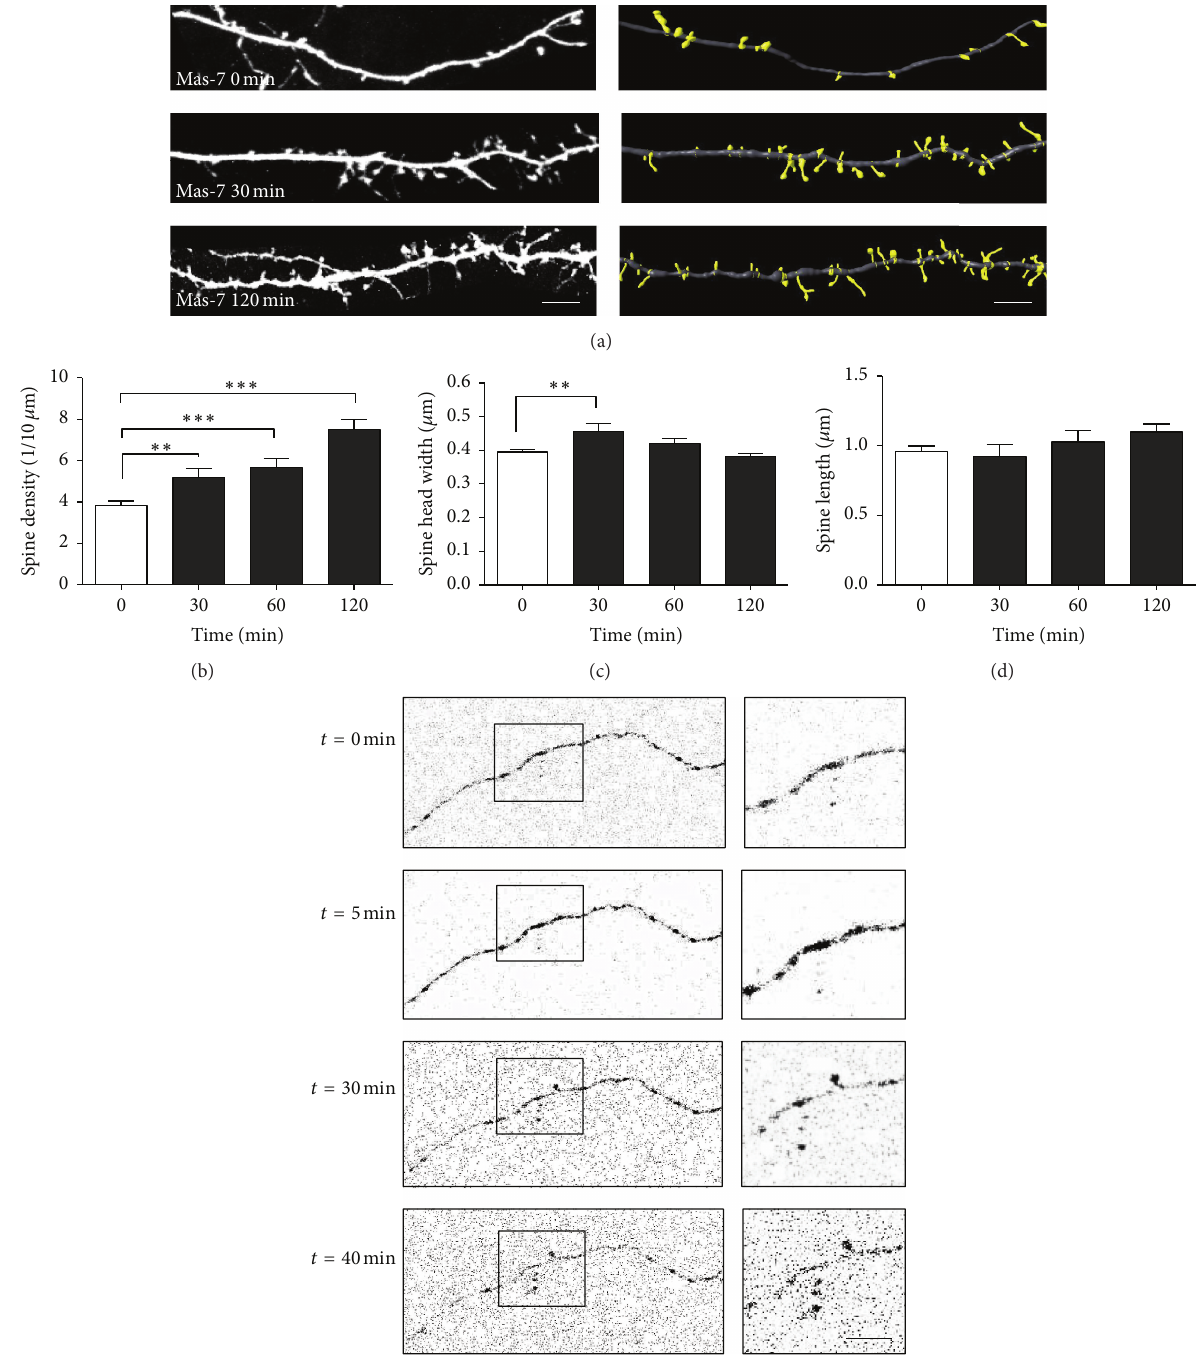
Figure 4: G 𝛼 o activation by Mas-7 regulates dendritic spine morphogenesis. (a) Left panel , representative images of 14 DIV hippocampal neurons treated with Mas-7 for 0, 30, or 120min. Right panel , 3D reconstructions of neurites. Scale bar = 5 𝜇 m. (b) Quantification of dendritic spine density. (c) Quantification of spine head width. (d) Quantification of spine length ( 𝑛 = 3 ). ∗∗∗ 𝑝 < 0.001 , ∗∗ 𝑝 < 0.01 , and ∗ 𝑝 < 0.05 . (e) Mas-7 induces de novo formation of dendritic protrusions. Live cell time-lapse imaging of the formation of dendritic spines in response to Mas-7 in 14 DIV hippocampal neurons. A dendrite of an EGFP-transfected neuron is shown before and after 5, 30, and 40min of treatment with Mas-7. Scale bar = 2 𝜇